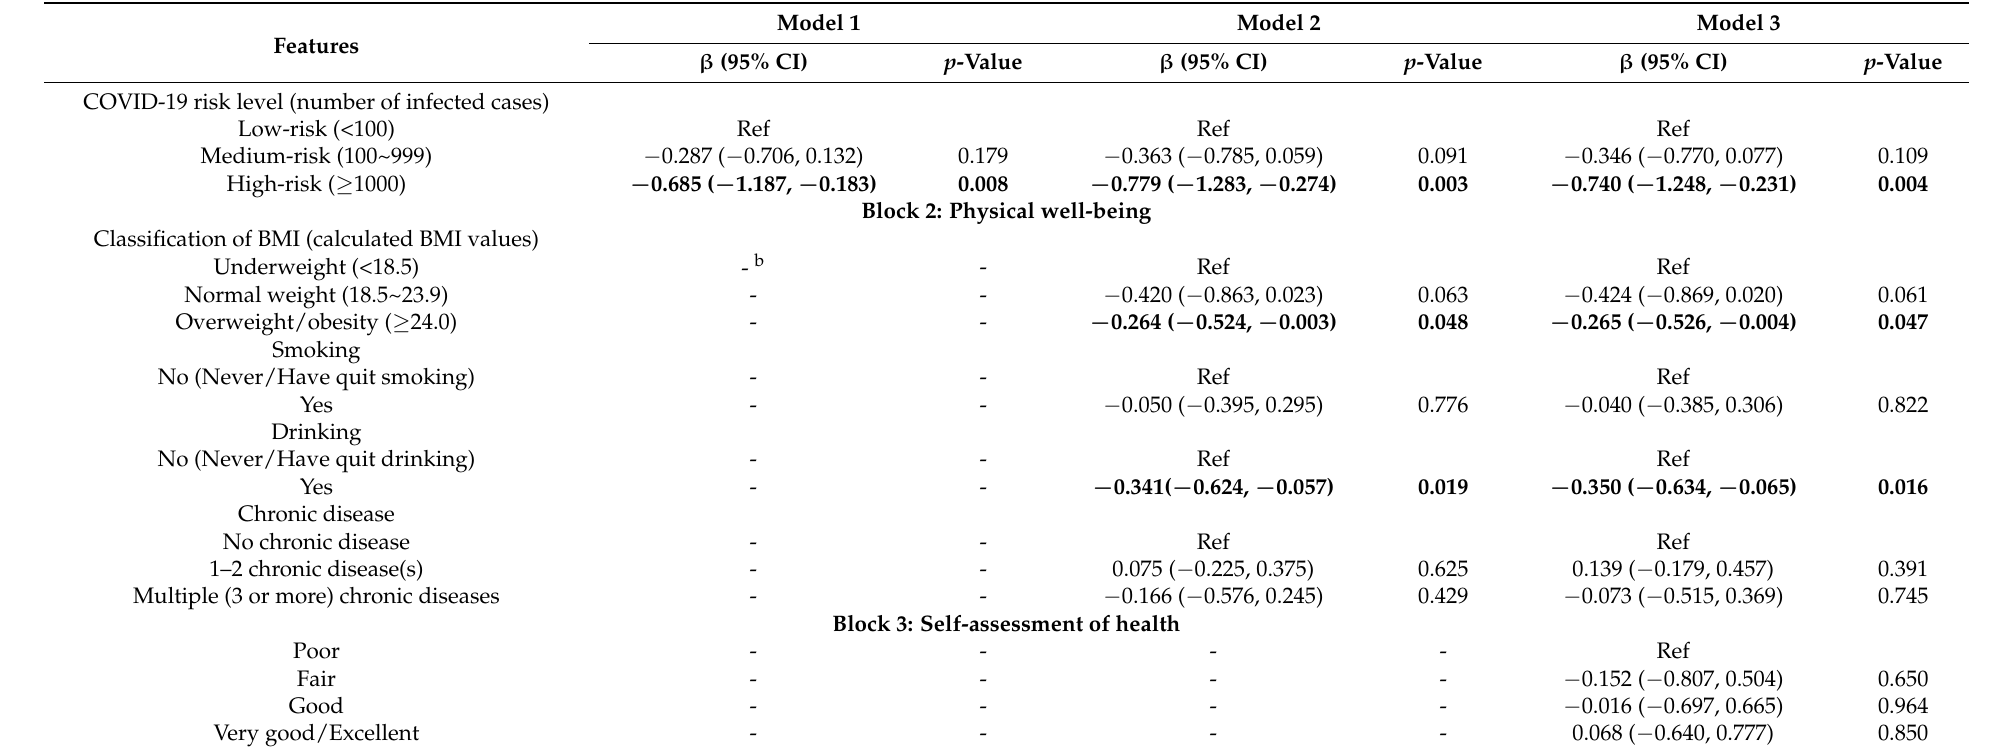
Table 4. Associated factors * impacted DHB among older Chinese during the COVID-19 pandemic ( n =